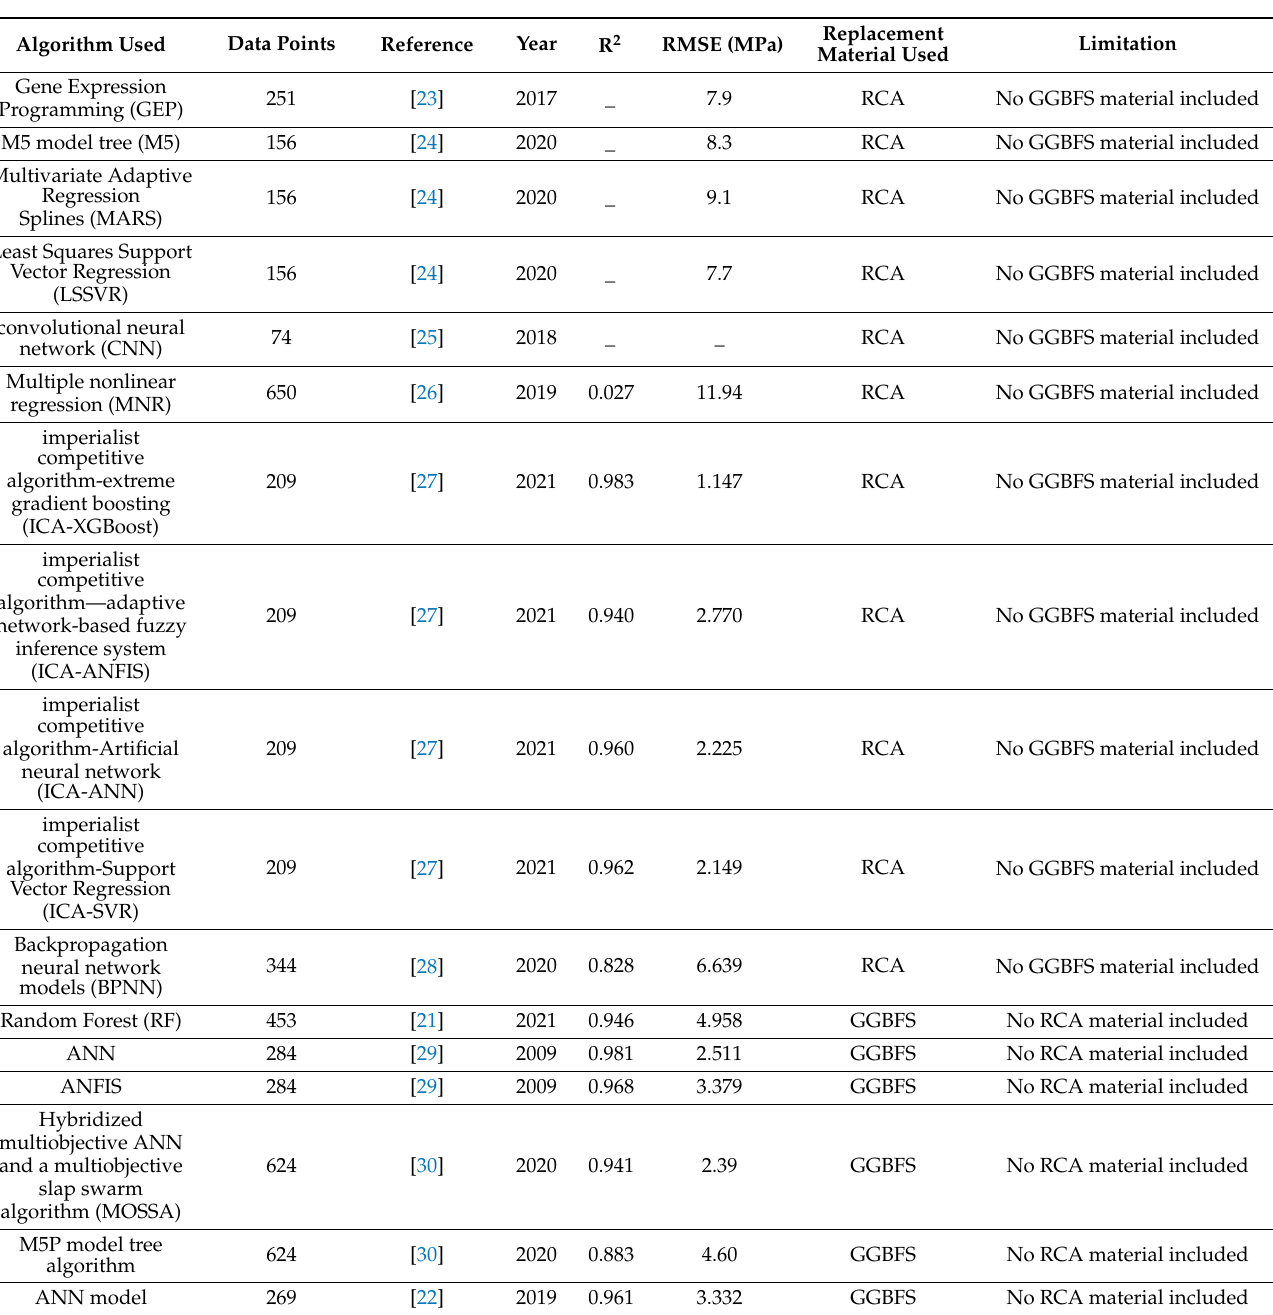
Table 1. Various algorithms to predict the Cs of eco-friendly